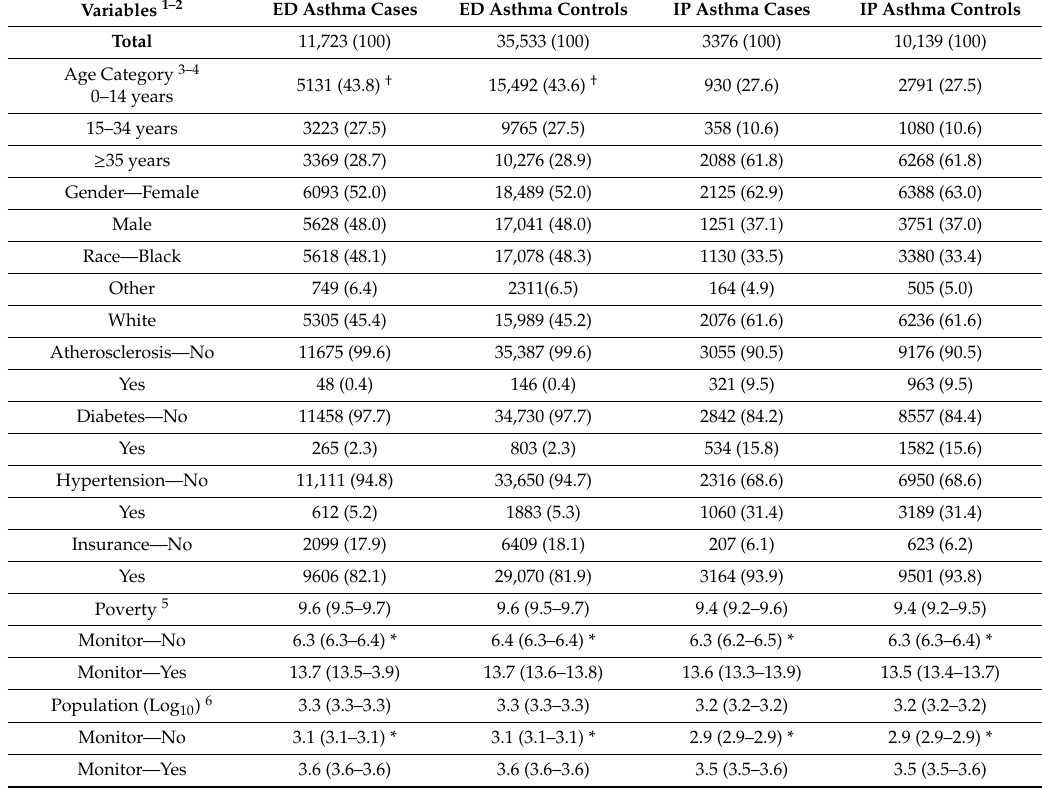
Table 1. Demographics for ED Asthma and IP Asthma Cases and Controls in the Baltimore